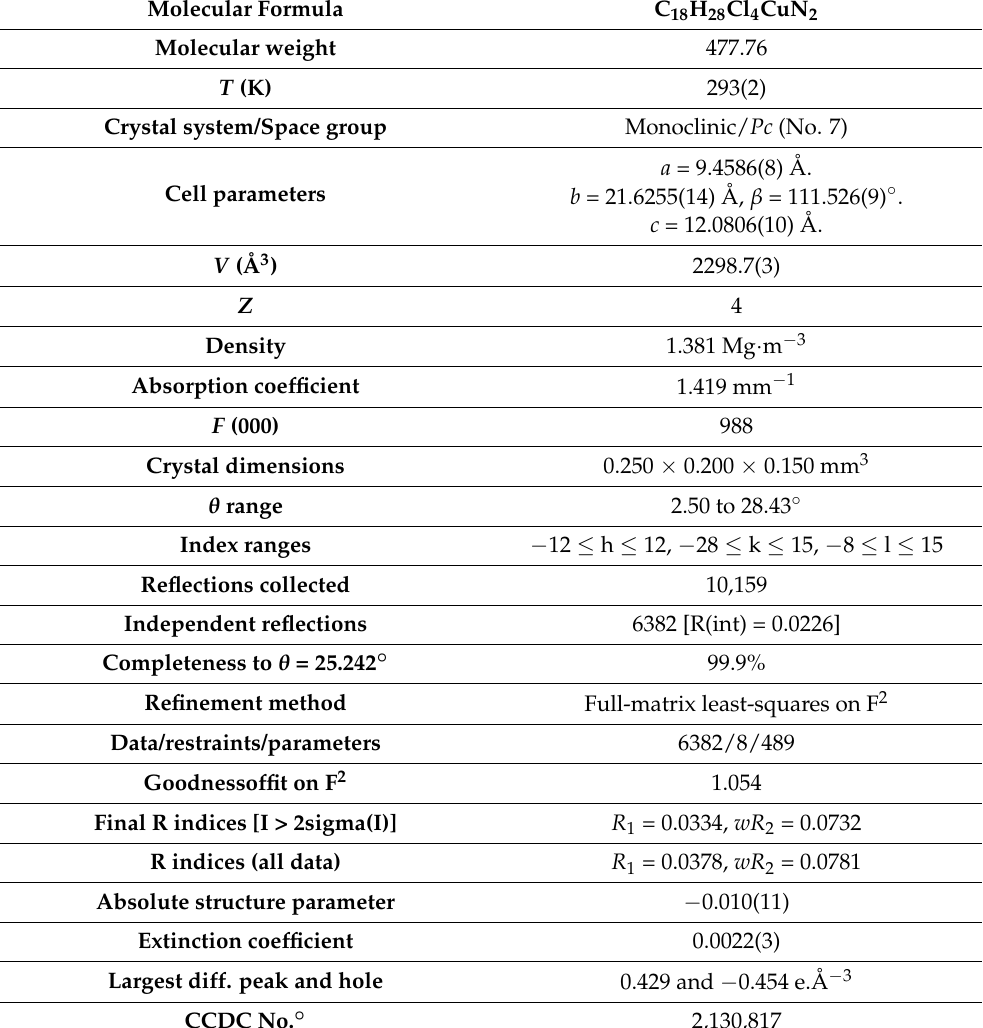
Table 1. Structure refinement and crystal